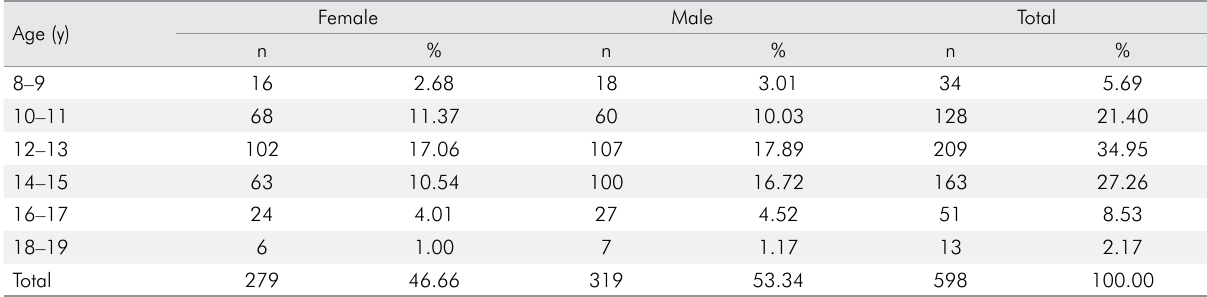
Table 2. Distribution of participants in the study, by age and sex